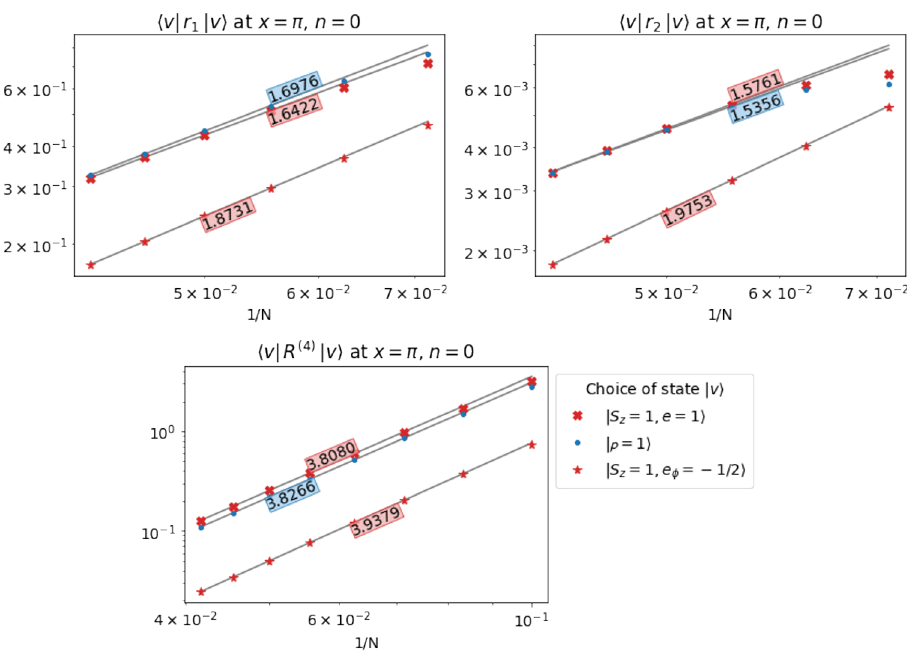
JHEP02(2021)130 Figure 11 . Absolute value of matrix elements, plotted using the same conventions as in (cid:12)gure 3 but with the choice of j u i = j v i . Figure 12 . Absolute value of matrix elements, plotted using the same conventions as in (cid:12)gure 3. In case of choices of j v i showing particularly strong (cid:12)nite size e(cid:11)ects ( j S z = 1 ; e = 1 i and j p = 1 i in upper two plots) the linear (cid:12)t is performed using only the two leftmost points. { 74